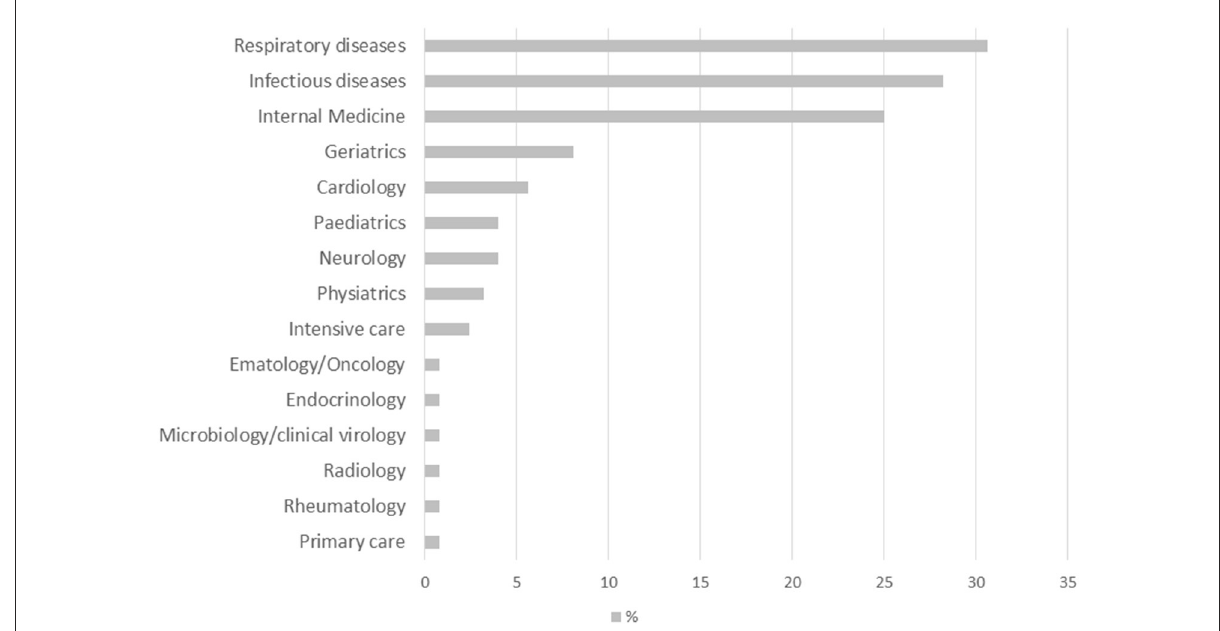
FIGURE1 Specialty of the clinical coordinator/head of the